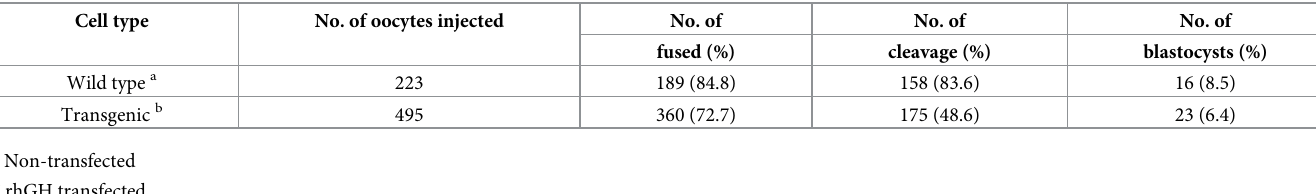
Table 2. In vitro development of transgenic pig embryos for SCNT.